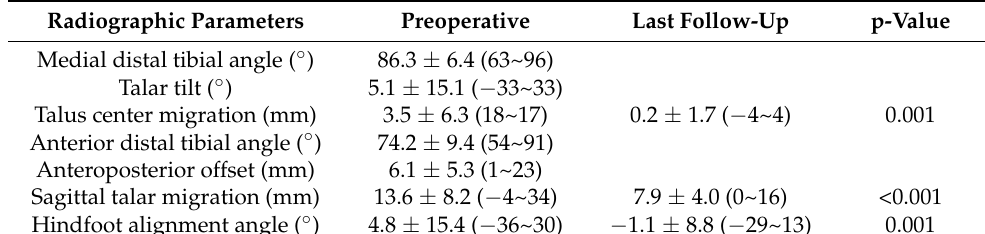
Table 1. Pre- and postoperative radiographic results.